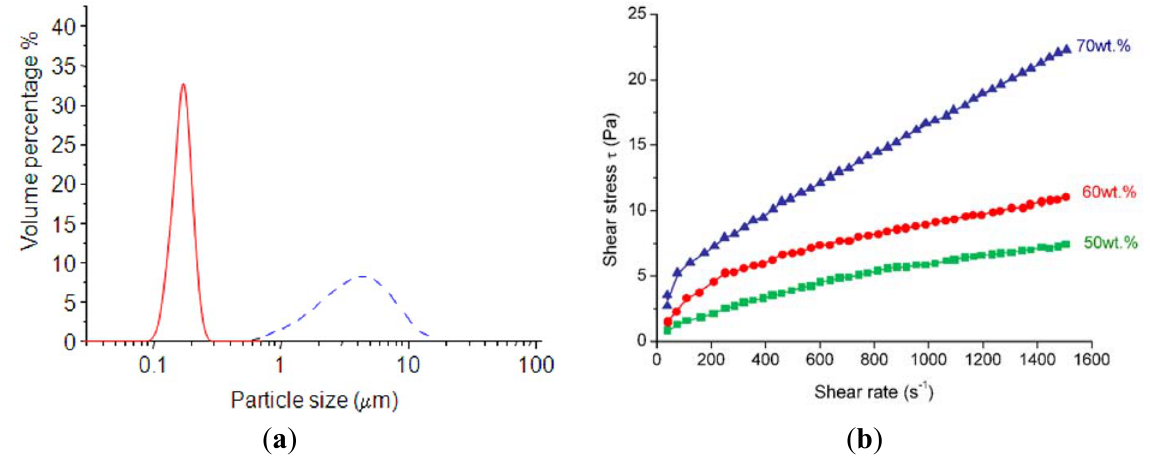
(red, solid line) dispersion; ( b ) shear stress vs. shear rate for AZ5 suspension, as a function of the solid loading.